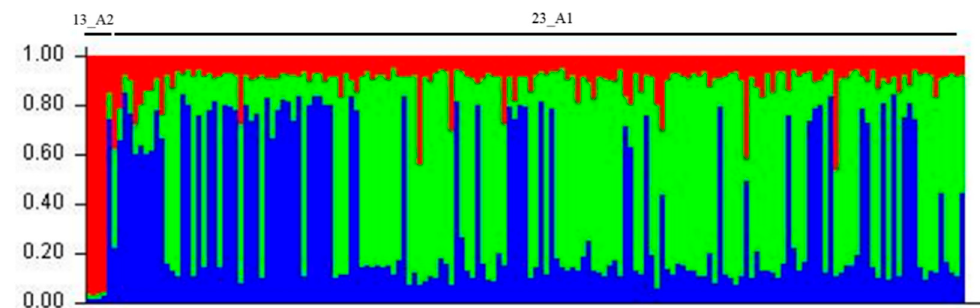
Figure 7. The principal components analysis (PCA) represents 167 selected isolates that were charac- terized using 12 SSR markers and examined in POLYSAT. PCA analysis revealed three major clusters: 13_A2 (represented in blue), 23_A1 (red) and unique lineage (green).